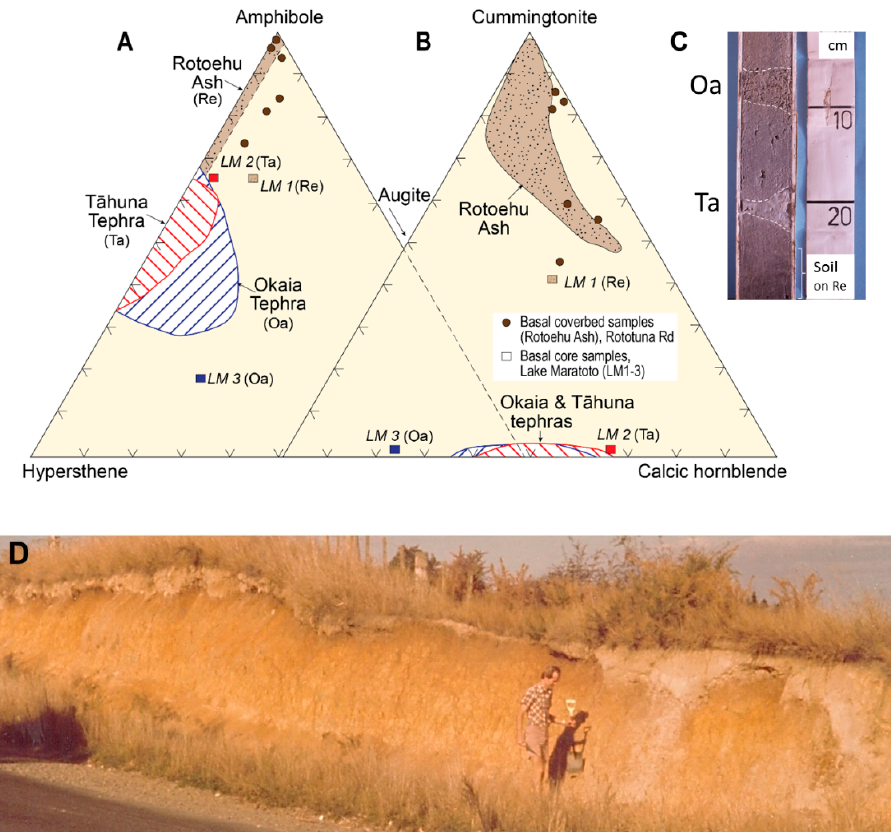
Figure 6. Ternary diagrams (A and B) showing relative abundances of ferromagnesian silicate minerals in compositional ‘fields’ (based on analyses of samples from known reference sites, see below) and comparison with analyses of samples from the coverbed (at Rototuna Road) and basal core samples, Lake Maratoto, showing their general similarity. ( A ) Amphibole (mainly calcic hornblende and cummingtonite), augite (clinopyroxene) and hypersthene (orthopyroxene). Data sources: Rotoehu Ash [18] (p. 298), [35] (p. 111, 383), [75] (p. 685–686), [93] (p. 69), [100] (p. 349), [101] (p. 2053); [102] (p. 349); T¯ahuna Tephra [93] (p. 69), [100] (p. 349); Okaia Tephra [93] (p. 69); basal coverbed samples, Rototuna Road [35] (p. 111, 383), [18] (p. 294); basal core samples LM1-3, Lake Maratoto [75] (p. 685–686). ( B ) Cummingtonite, hypersthene (orthopyroxene) and calcic hornblende. Data sources as for (A). ( C ) Photograph of 30-cm-long part of a core from beneath Lake Maratoto (core number 4 , 1f in Reference [75] p. 687). It shows pumiceous Okaia (Oa) and T¯ahuna (Ta) tephras preserved as c. 5-cm-thick layers in pale (reduced) brownish-grey muds inferred to be pre-lake colluvial deposits (mainly reworked Okaia and T¯ahuna tephras). These deposits overlie a weakly developed greyish-brown soil horizon on Rotoehu Ash (Figure 5). Photo: D.J. Lowe. ( D ) Road cut exposing the coverbed overlying the paleosol on Hamilton Ash at Rototuna Road at c. 39 m above sea level (asl) in Hamilton (Figure 1), very near the intersection with Cate Road (37 ◦ 44 (cid:48) 03” S, 175 ◦ 16 (cid:48) 05” E). The exceptionally dry conditions have allowed (almost pure) Rotoehu Ash to stand out as a distinct white layer c. 0.2 m-thick at the base of the coverbed in the two paleo-hollows to the right of the person. The white ash material, being slightly less weathered and hence less (weakly) cemented and less coherent, has broken away somewhat from the face of the section and some of it has fallen or washed down over the reddish-brown surface of the Hamilton Ash beds beneath the deep hollows. The Rotoehu Ash could have been somewhat overthickened to c. 0.3 m thickness in the deepest hollow (with steepened sides) soon after deposition. The five basal coverbed samples analysed mineralogically and plotted in the ternary diagrams A and B were collected from basal deposits in three locations at this site including at c. 1.1 m depth in the deepest hollow at far right (after [35] pp. 39 and 42). Photo: D.J.